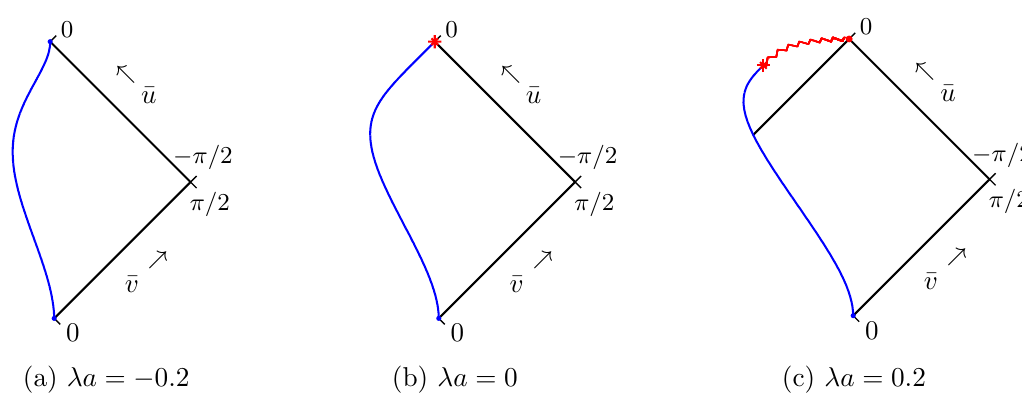
Figure 5 . Solution (3.10) in the (cid:12)nite-range coordinates (cid:22) u = arctg( (cid:21)u ), (cid:22) v = arctg( (cid:21)v ) at di(cid:11)erent values of a . We use (cid:21)b = e 2 (cid:30) 0 = 1 keeping in mind that the parameter e 2 (cid:30) 0 (cid:28) 1 can be restored in the classical solution, see discussion in section